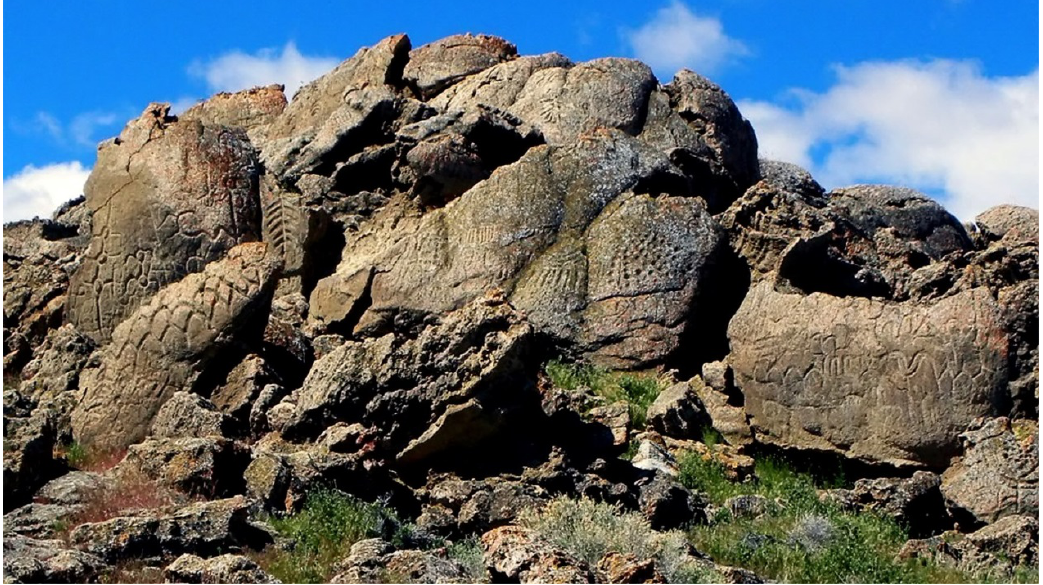
Figure 1. Final Pleistocene petroglyphs on tufa deposit at Winnemucca Lake, western Nevada (photograph by L.